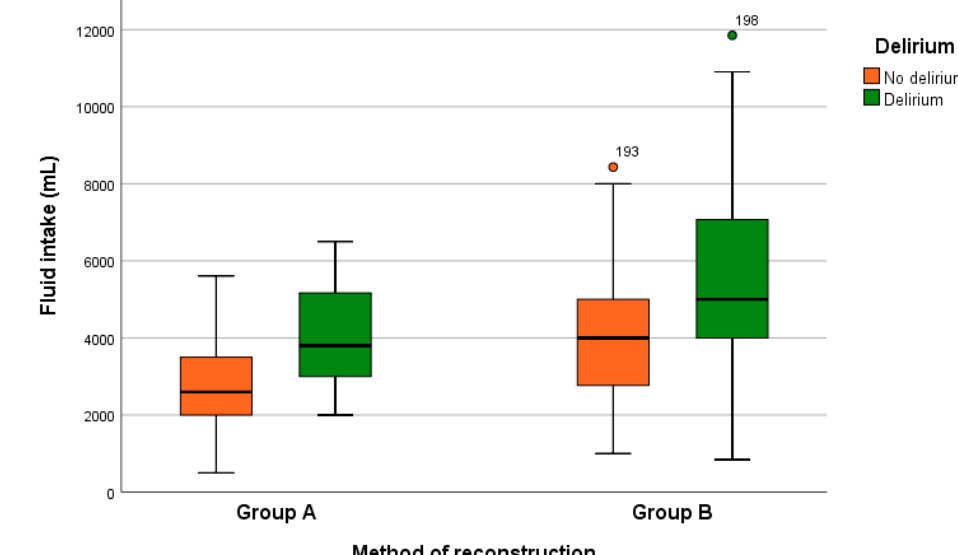
Figure 1. Occurrence of delirium for different surgical procedures concerning fluid intake. A total of 18.2% of the patients in group A and 48% of the patients in group B develop delirium. (Group A: reconstruction with primary wound closure or local flap. Group B: microsurgical reconstruction with free flap).